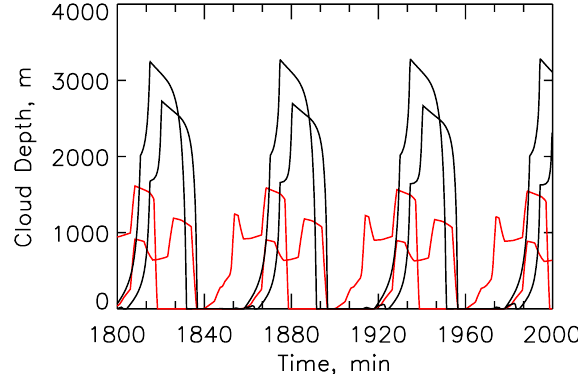
Fig. 5. As in Fig. 4 but with | η | reduced to − 0.53. The small reduc- tion in | η | results in incoherent oscillations and suggests a threshold for synchronization.